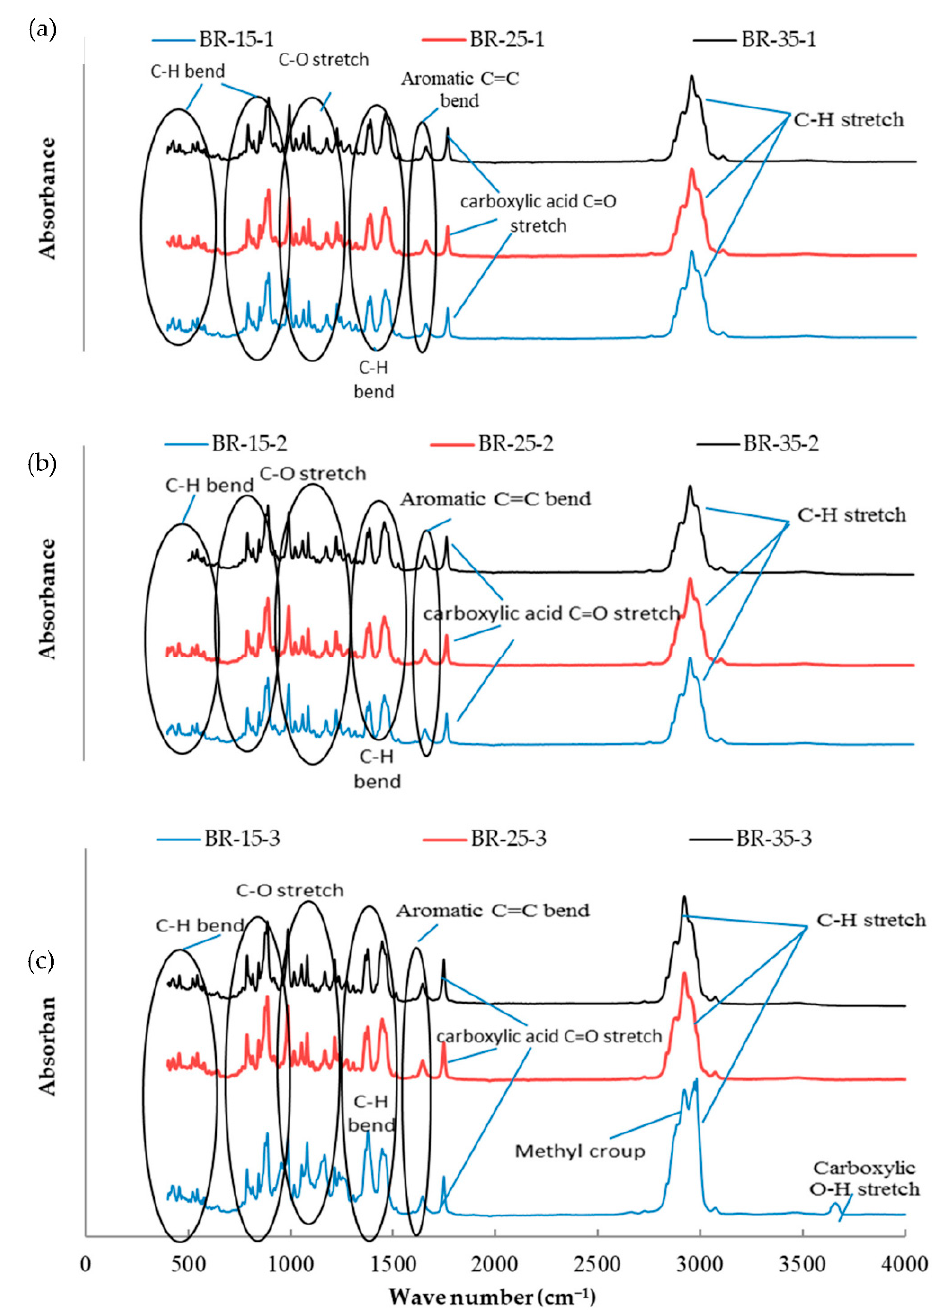
Figure 2. Fourier-transform infrared spectroscopy (FTIR) analysis for the essential oil combination of black pepper + rosemary (BR) at different temperatures (15, 25, and 35 ◦ C) and different times of storage (1–3 months) (different colors refer to different temperature per subfigure). ( a ) This figure refer to the effect of different temperature at 15, 25, and 35 ◦ C on the combination of BR stored for one month; ( b ) the second subfigure refer to different temperature at 15, 25, and 35 ◦ C on the combination of BR stored for two months; ( c ) the third subfigure refer to different temperature at 15, 25, and 35 ◦ C on the combination of BR stored for three months.